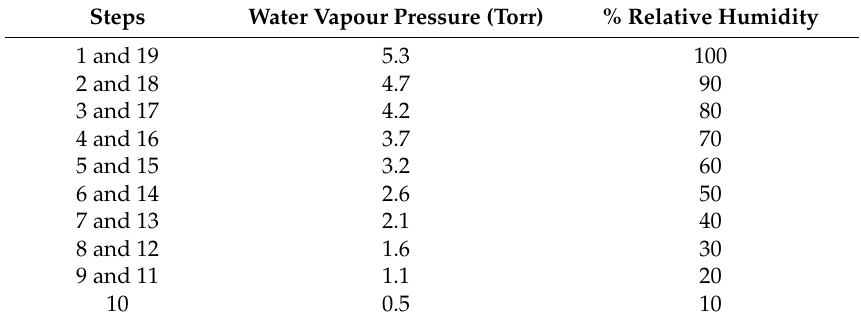
Steps Water Vapour Pressure (Torr) % Relative